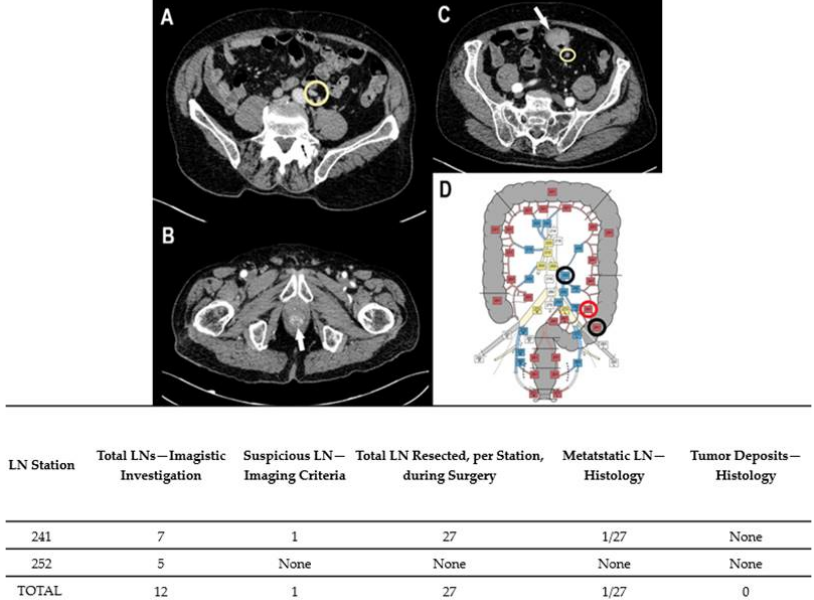
Figure 3. Case No. 4: synchronous sigmoid ADK and SCC of the anal canal. Circumferential thickening with inhomogeneous enhancement at the level of sigmoid, proves infiltration of the mesenteric fat (white arrow). Perisigmoid and inferior mesentery LN stations were seen on contrast-enhanced CT, venous phase, axial views ( A , C ). The tumor mass in the anal region shows heterogenous enhancement in the arterial phase ( B ), with no visible LNs. ( D ) A map of nodal stations involved was made: black circle—visible LN, without suspicious features; red circle—suspicious LN for malignancy. Table: map correlation showed that positive LN was successfully detected on CT scan.